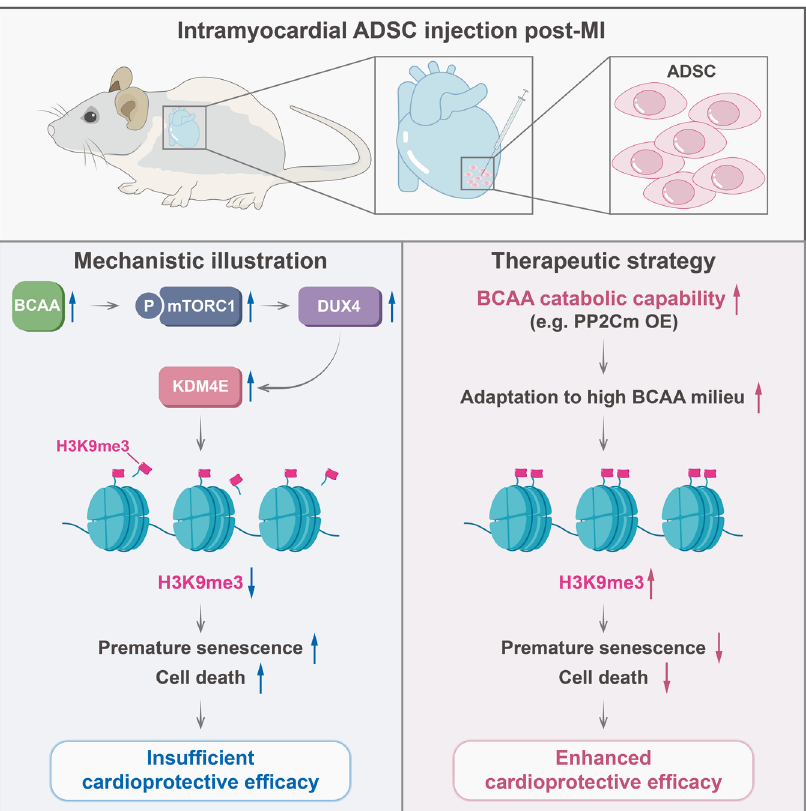
Fig. 8 Schematic illustration. After MI, myocardial BCAA catabolism is disrupted, and BCAA are aberrantly accumulated in the post-ischemic heart. Excessive BCAA accumulation in the post-MI heart milieu results in the activation of mTORC1 signaling, the upregulation of DUX4 and KDM4E, and the loss of H3K9me3 in MSCs implanted into the post-ischemic heart. The loss of H3K9me3 drives premature senescence and death of implanted MSCs, thus restricting their cardioprotective effects. Boosting BCAA catabolism in MSCs via appropriate approaches (e.g. PP2Cm overexpression) can improve the adaptation of MSCs to the high BCAA milieu in the post-MI heart, increase the retention of MSCs after the implantation, and strengthen the therapeutic ef fi cacy of MSC-based